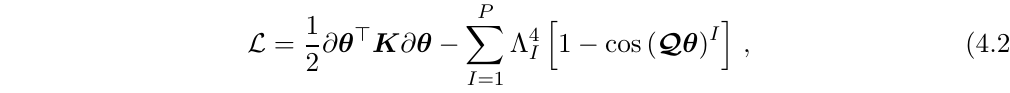
Figure 14 . Illustration of the tile 1 N . The diameter is enhanced by